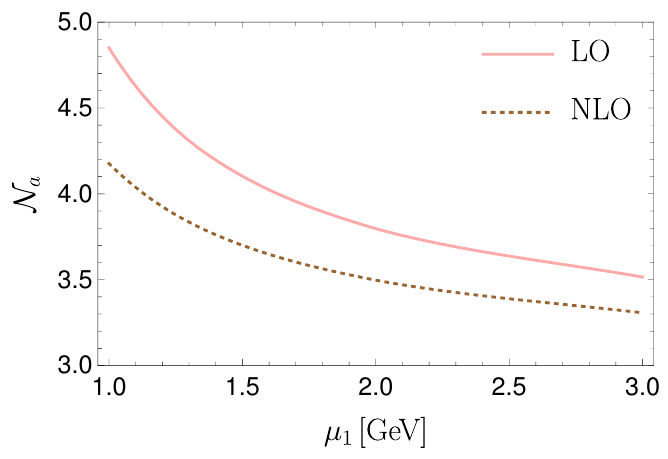
Figure 2 . Scale dependence of the Wilson coefficient combination N a = 3 C 2